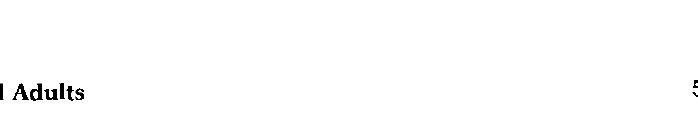
Table 2: Teicher's taxonomy of word-finding strate- gies (Teicher,